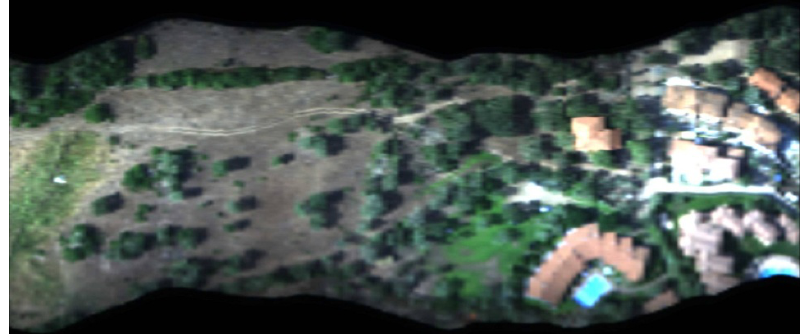
Figure 16. Hyperspectral cube representation in RGB using images at bands 660 nm (R), 560 nm (G) and 480 nm